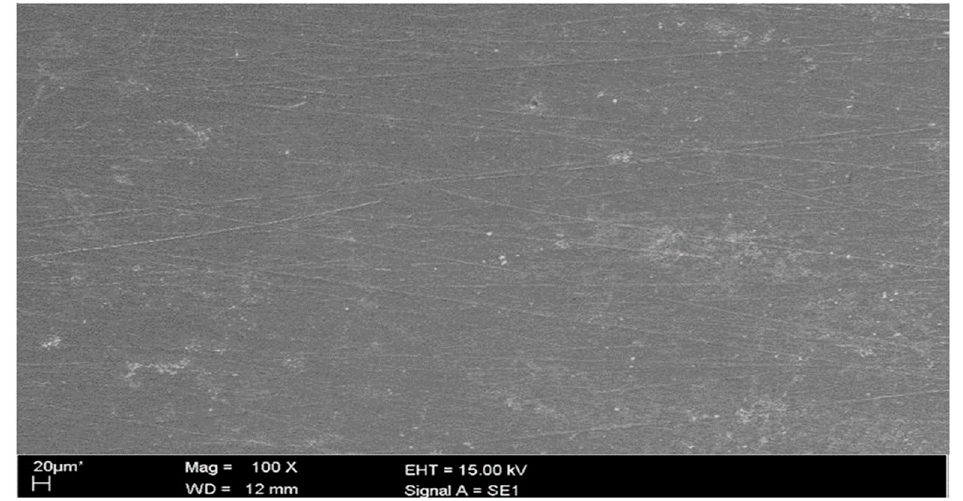
Figure 11. The SEM micrograph for mild steel in a corrosive solution in the presence of the corrosion inhibitor.